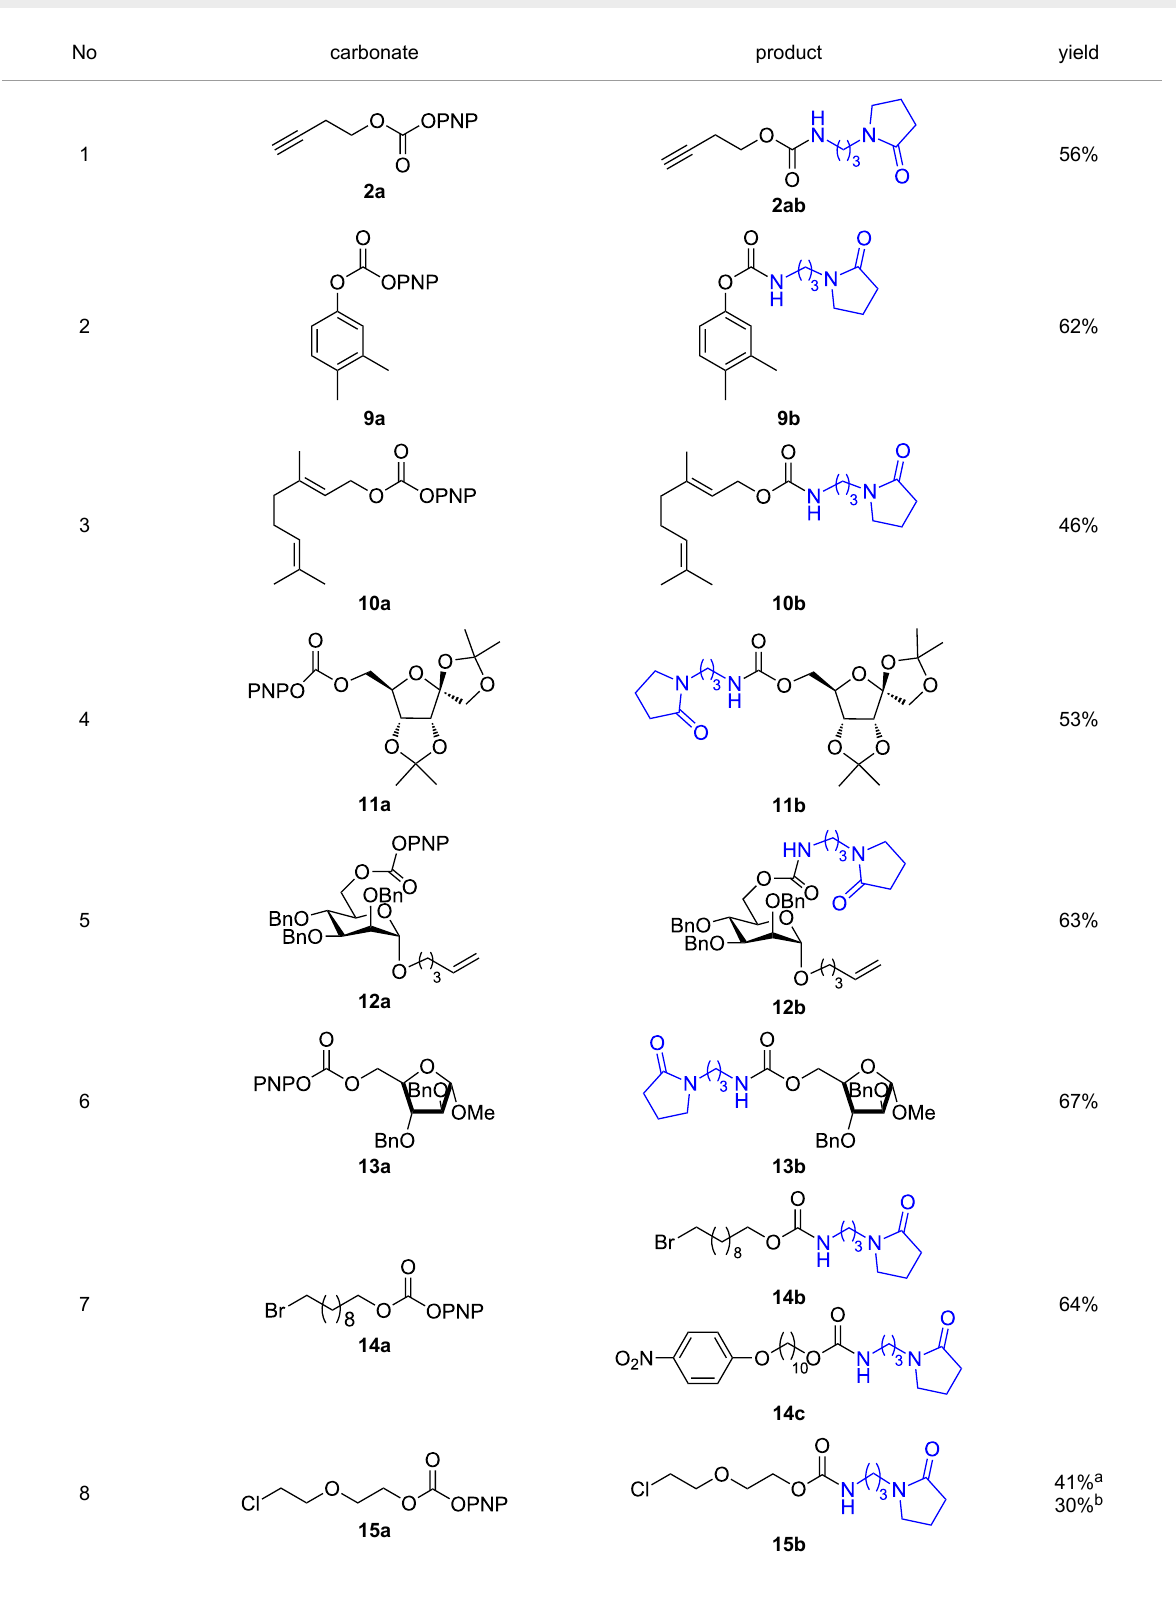
Table 2: Synthesis of γ -lactam-derived carbamates 2ab , 9b–16b .